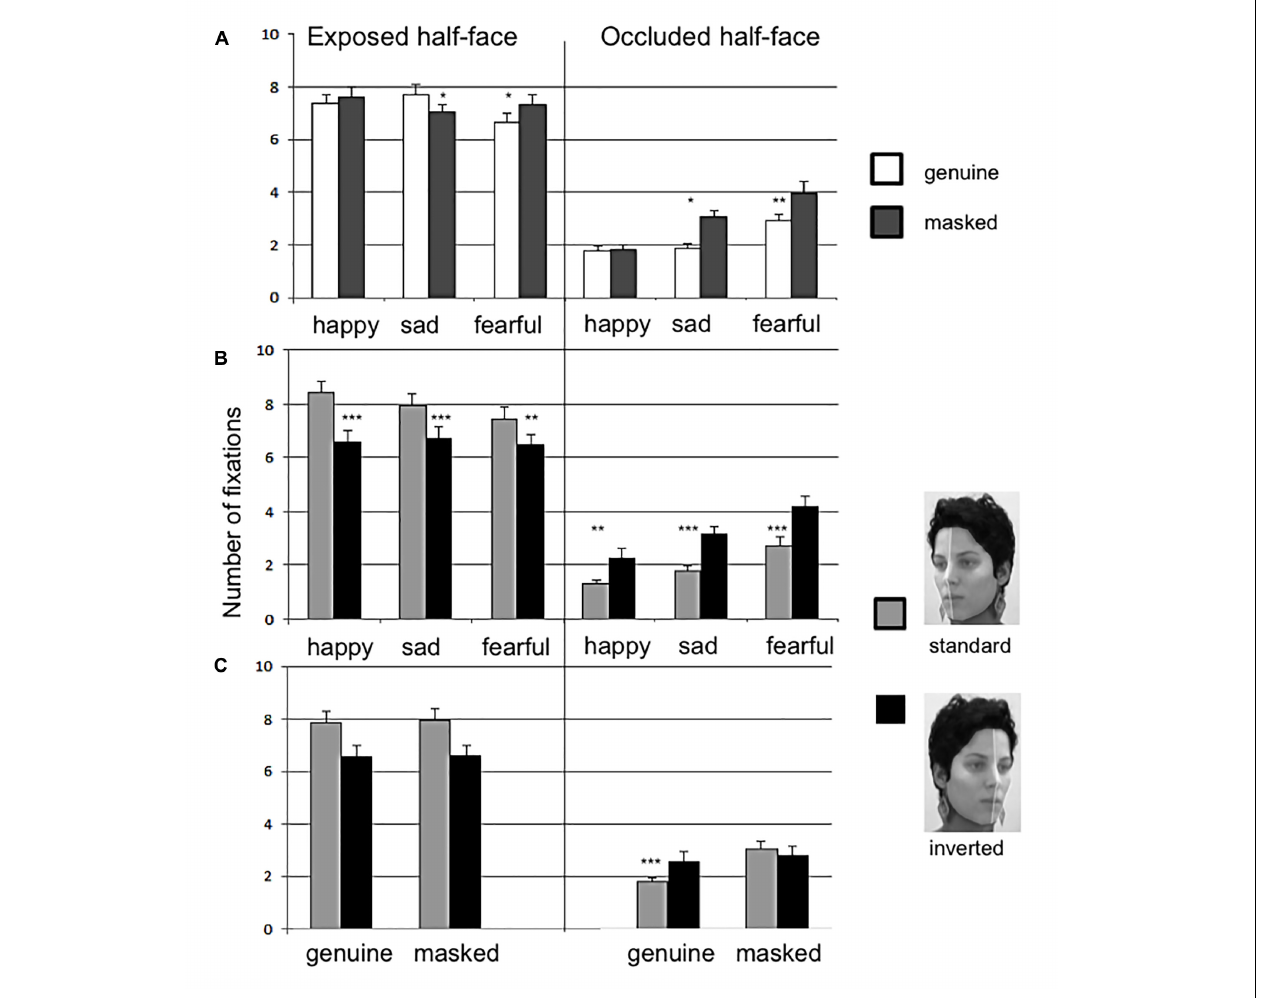
FIGURE 2 | The number of fixations on the ROIs. Exposed half-face (left side) and occluded half-face (right side) graphs show distribution of fixations in interaction with emotion and veracity (A) ; emotion and side (B) ; and veracity and side (C) . The error bars show standard error and statistical significance is marked by ∗ p < 0.5; ∗∗ p < 0.01; ∗∗∗ p <